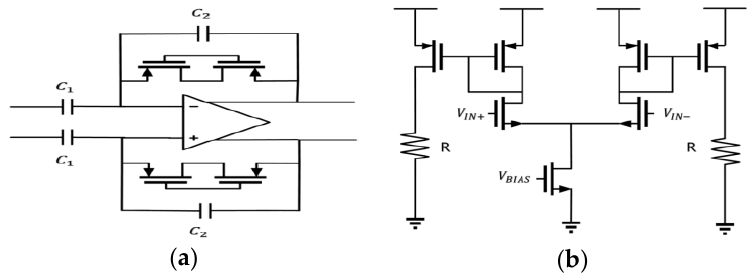
Figure 11. Circuit of ( a ) amplifying stage and ( b ) output stage. An automatic gain control (AGC) circuit is used to control the output swing of the MEMS oscillator by giving a reference voltage. The AGC circuit consists of a peak detector and an integrator. The operating principle is illustrated in Figure 12a. V out ; the output voltage of the oscillator is comparable to the voltage stored on C 1 with an amplifier. If V out is greater than V C 1 , the output of the amplifier will be raised and close to the supply rail ( V DD ). The voltage on C 1 will increase because of the charging current from the low-threshold voltage n-type MOS (NMOS) device. Besides, if V out is smaller than V C 1 , V C 1 will be pulled down to the ground by the discharging NMOS. Thus, by balancing the charging and discharging speedwell, V C 1 can follow the peak value of V out .